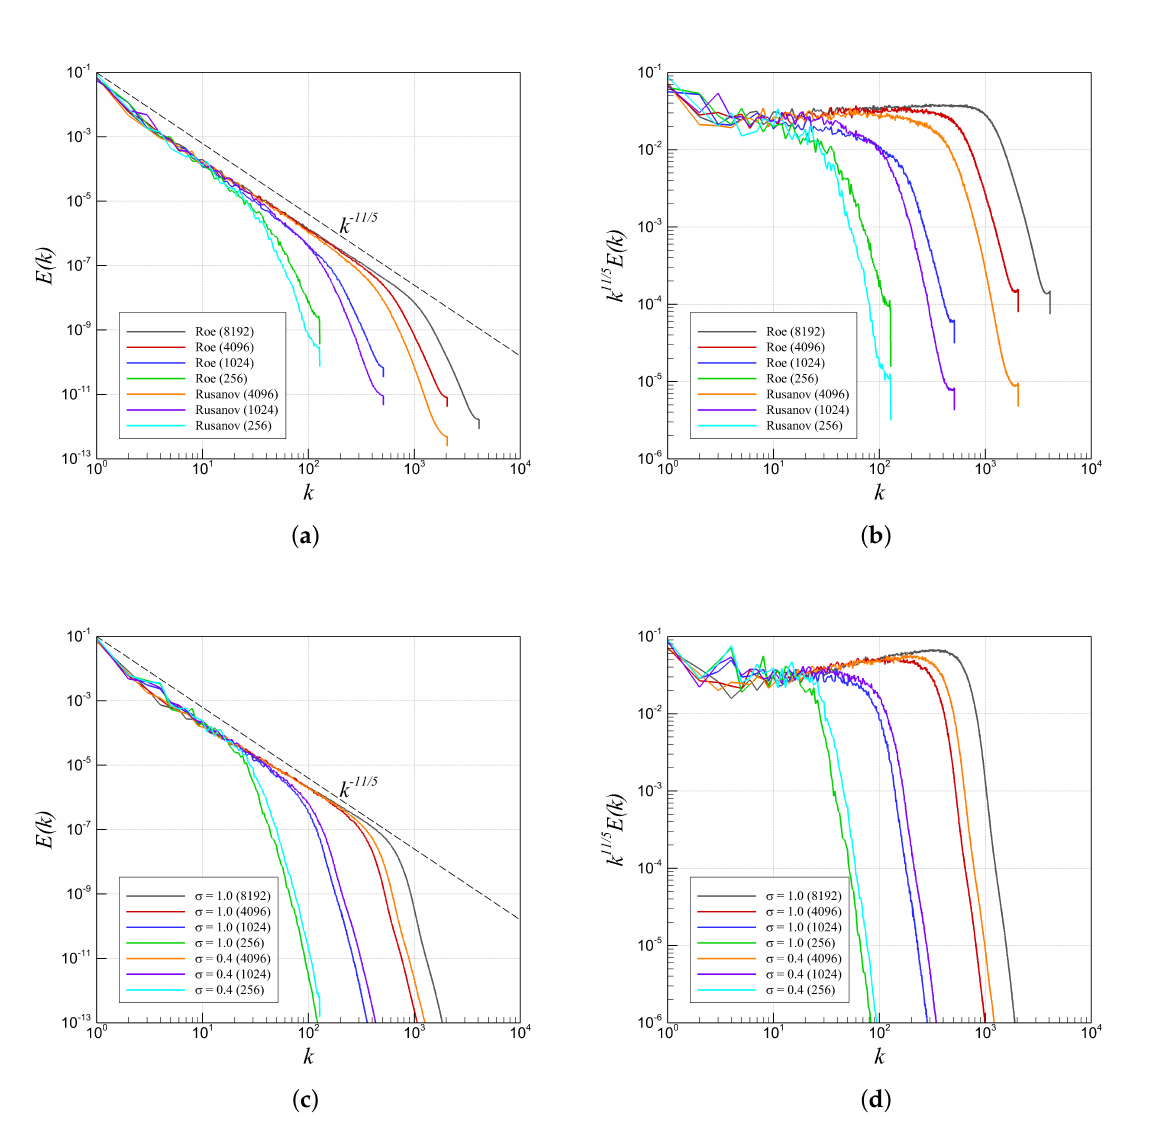
Figure 23. Comparison of ILES (ILES-Roe and ILES-Rusanov) models and CS+RF ( σ = 1.0 and σ = 0.4) models at different resolutions for the RTI problem with single-mode perturbation showing the density-weighted kinetic energy spectra and compensated density-weighted kinetic energy spectra; ( a ) density-weighted spectra using ILES solvers; ( b ) compensated density-weighted spectra using ILES solvers; ( c ) density-weighted spectra using CS+RF solvers; ( d ) compensated density-weighted spectra using CS+RF